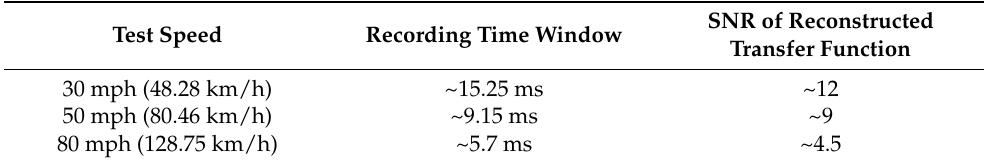
Table 3. Compromise values between test speeds, recording time window and SNR of the passively reconstructed transfer function achieved in field